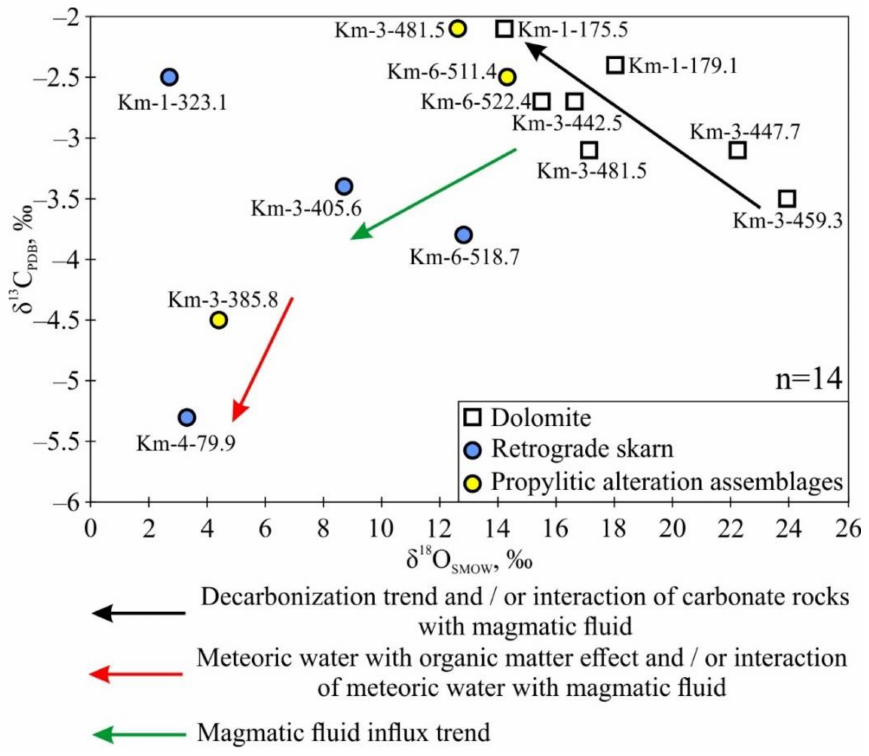
Figure 23. δ 13 C PDB and of δ 18 O SMOW plots for hydrothermal carbonate minerals and dolomites from host